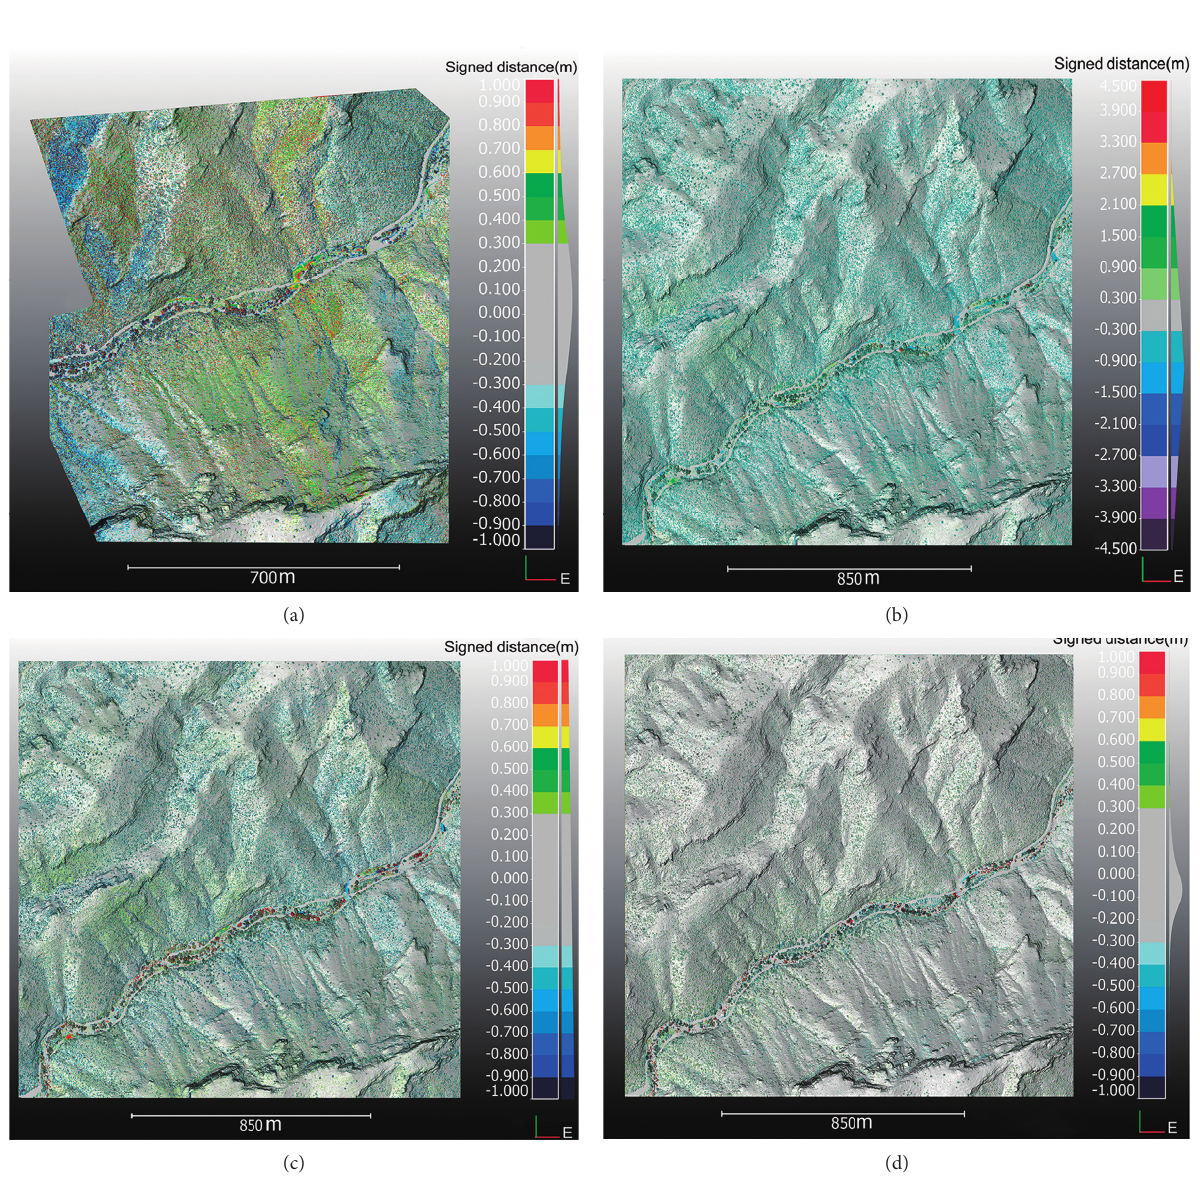
Figure 6: The result of distance computation.